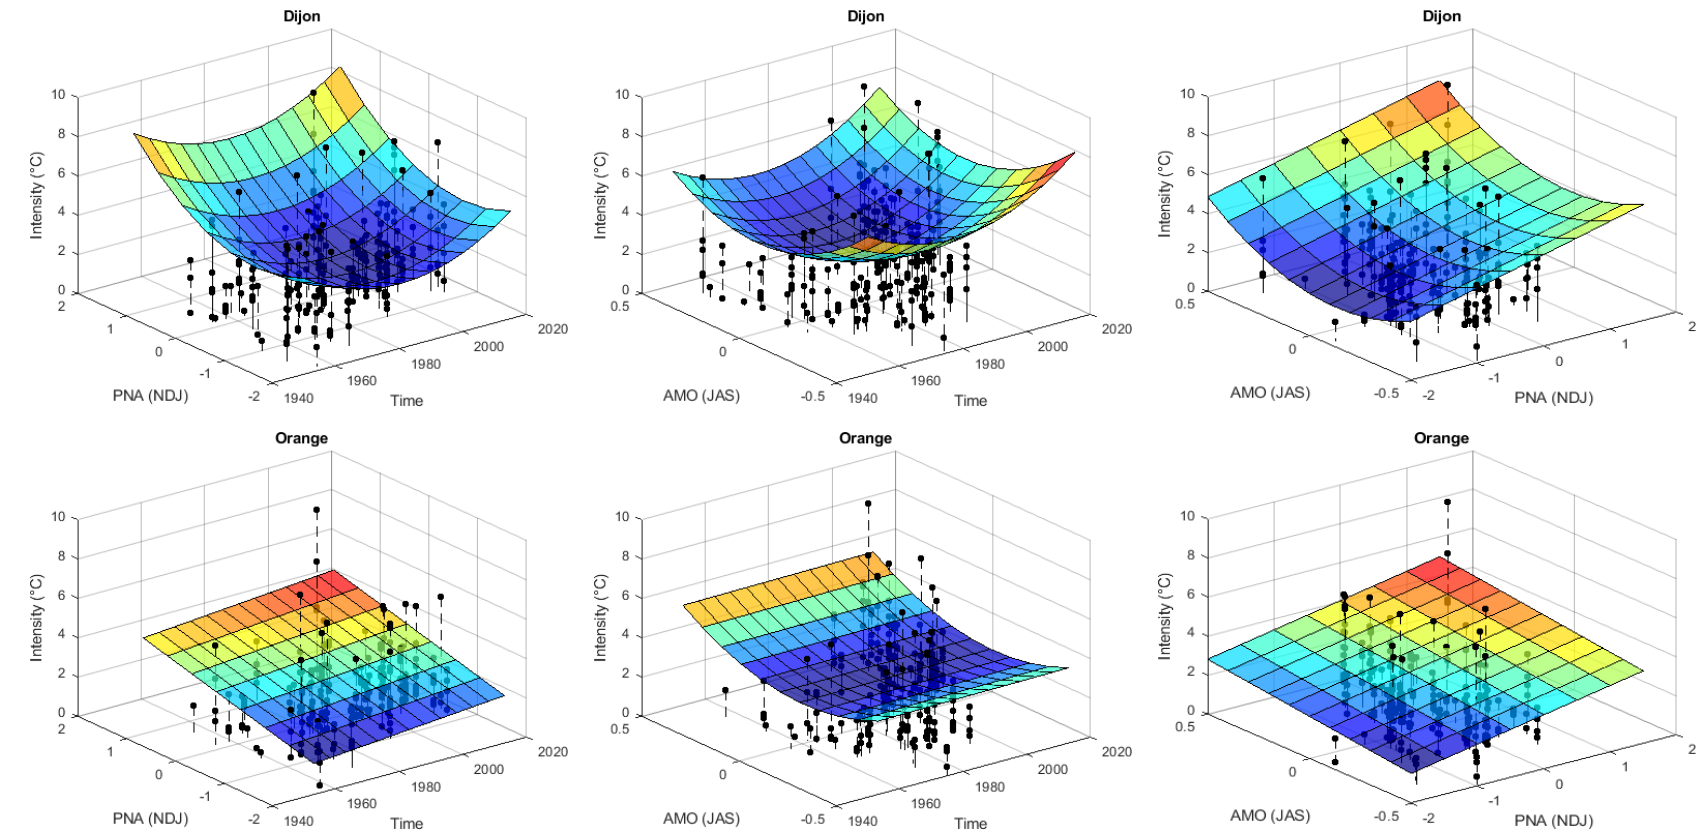
Figure 10. Intensity quantiles corresponding to the non-exceedance probability p = 0.9 as a function of the combination of two covariates.